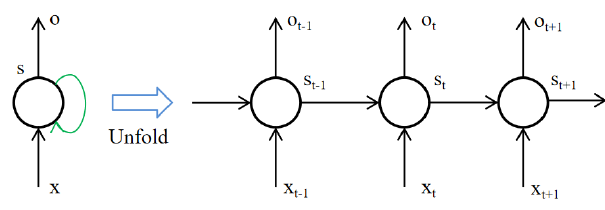
Fig. 3 Unfolding of RNN in time domain.